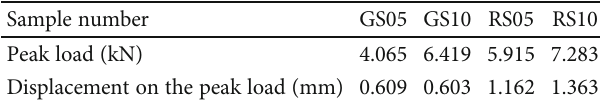
Table 2: The peak values for di ff erent